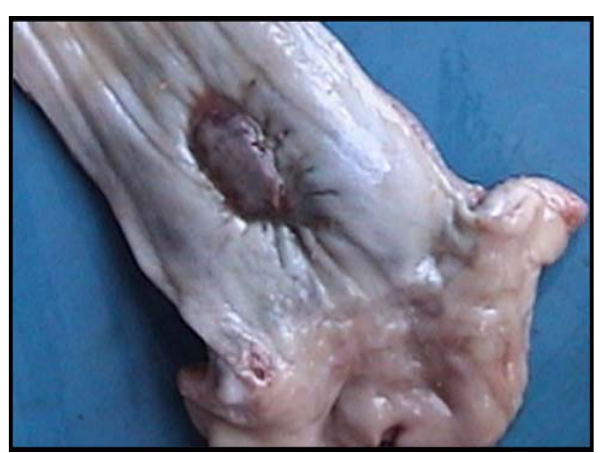
FIGURE 3 - Luminal face of dog´esophagus submitted to esophagoplasty with diaphragmatic flap